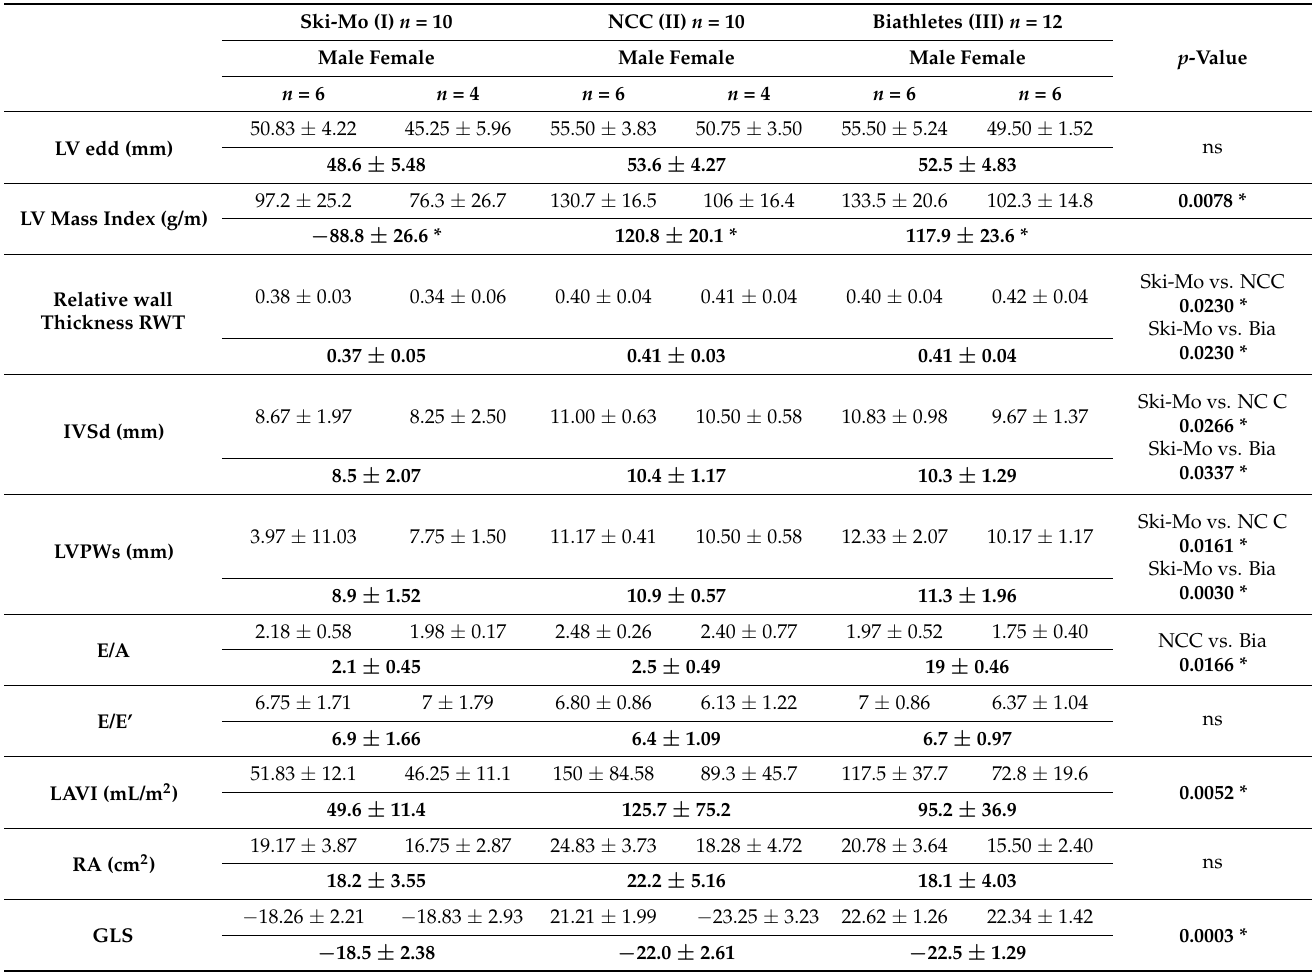
Table 3. Echocardiographic Measurements in elite winter sport athletes, adapted from Zimmermann et al., 2021